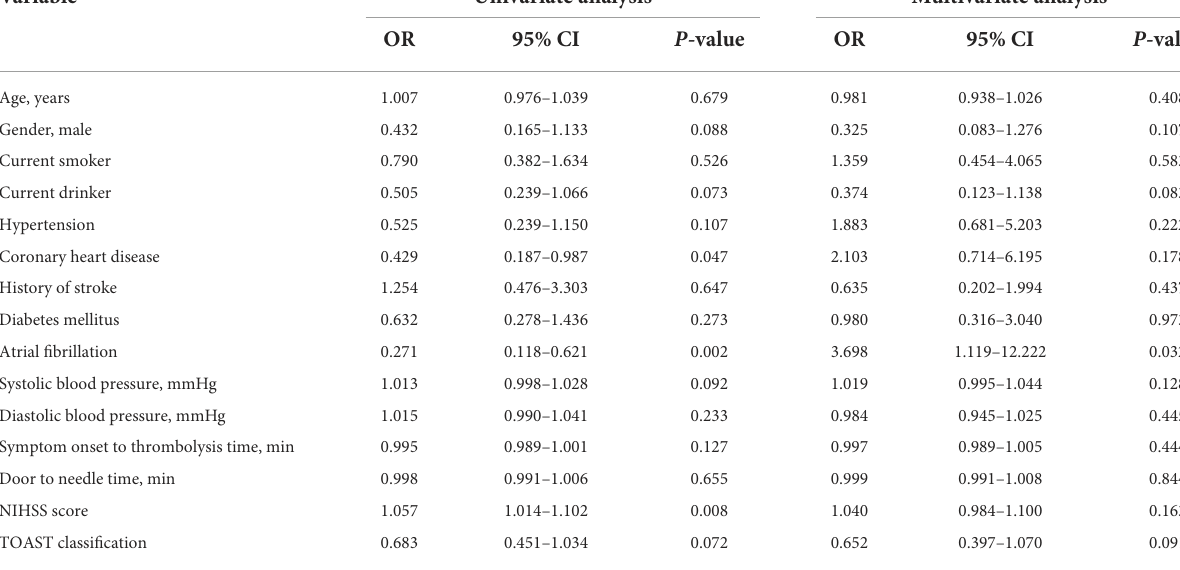
TABLE 5 Univariate and multivariate logistic regression analysis to predict sICH (OR and 95% CI).